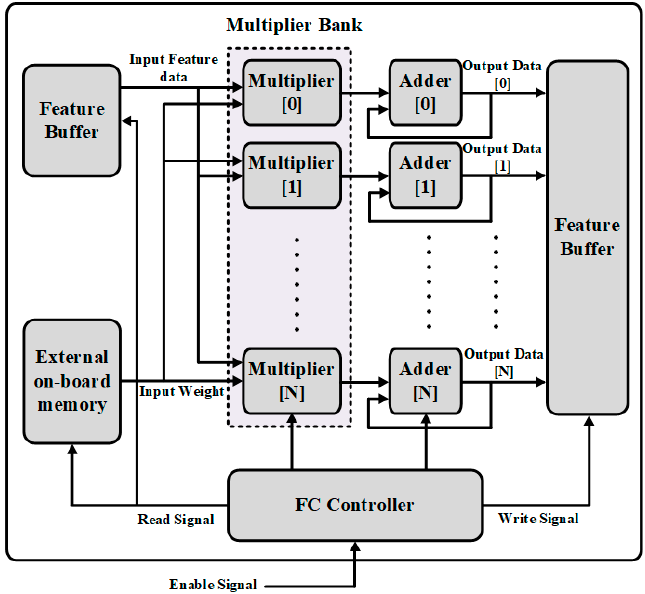
Figure 11. The architecture of the fully connected operation.